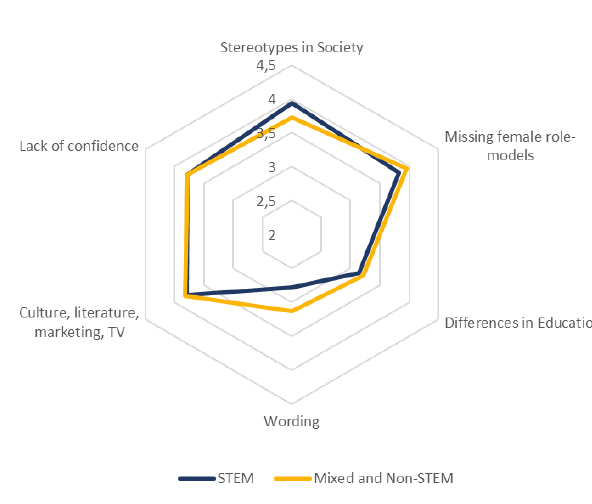
Figure 6. Bain barriers choosing STEM education depending on education type